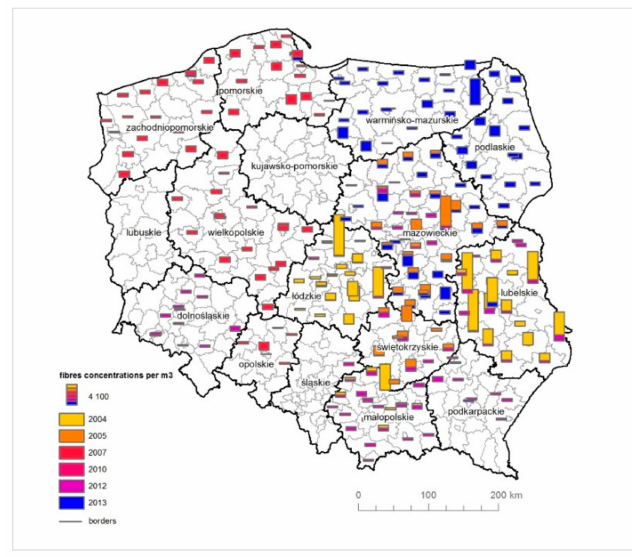
Figure 5. The results of measurements of the asbestos fibre concentrations in the air by counties with regards to the period of 2004–2013 (fibres / m 3 ).